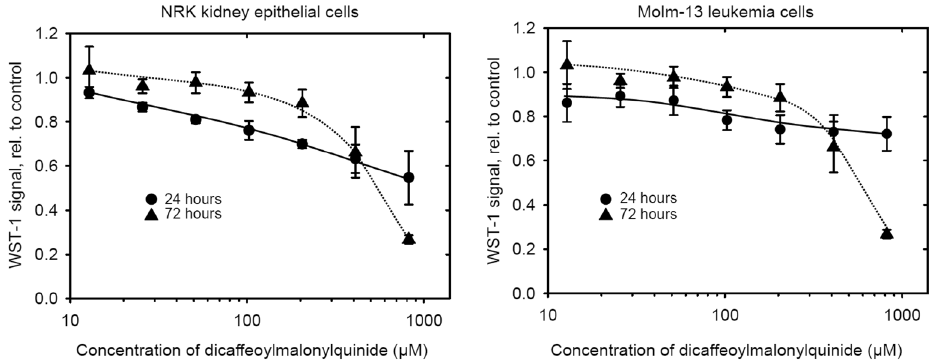
Figure 2. Cytotoxicity of 1,3-dicaffeoyl-5-malonyl-δ-quinide ( 1 ) towards NRK kidney epithelial cells and Molm-13 leukemia cells. The figure was created with SigmaPlot 14 (Systat Software, Inc., San Jose, CA, USA). https:// systa tsoft ware. com/ sigma